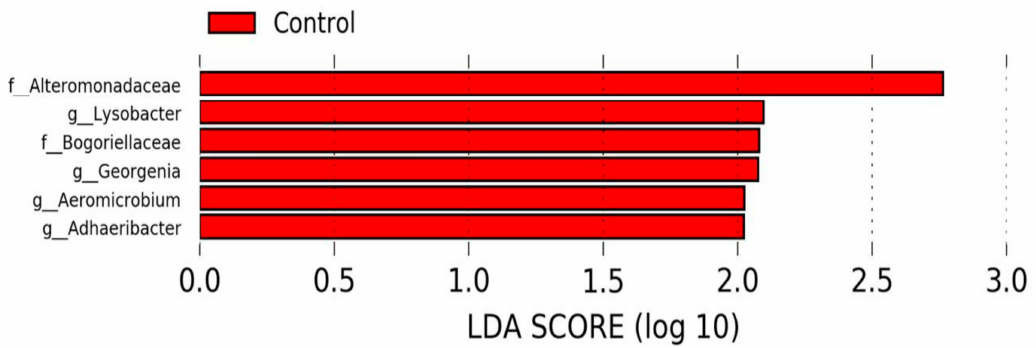
Figure 7. Differentially abundant taxa identified using LEfSe showing taxa that were enriched in calves from control dams at weaning ( α = 0.05, LDA score >